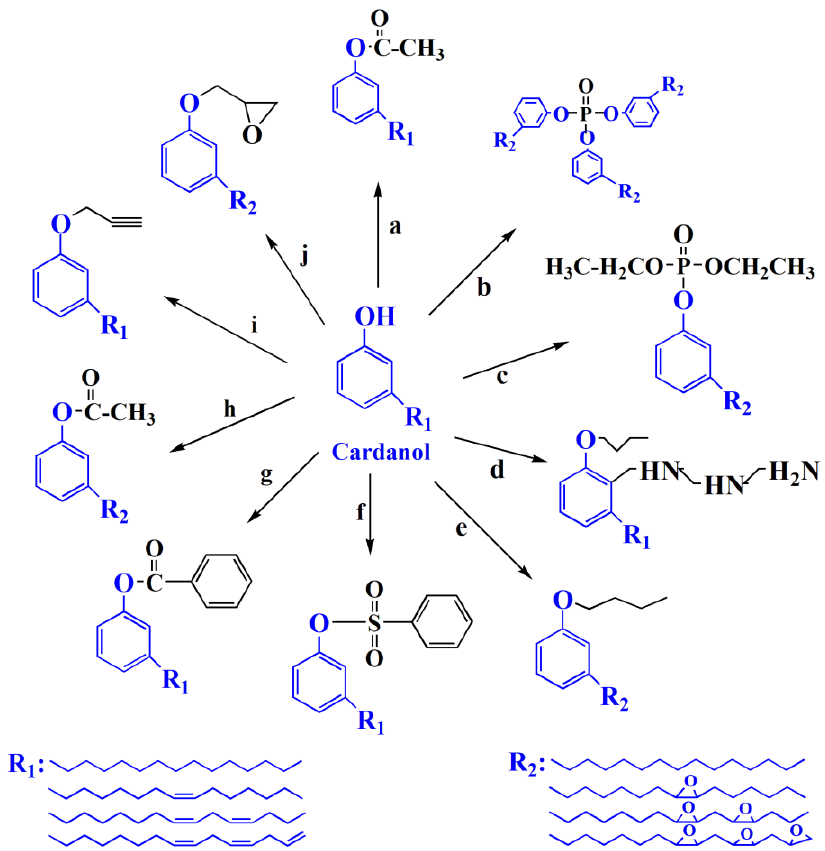
Figure 5. Chemical structure of cardanol based plasticizer.